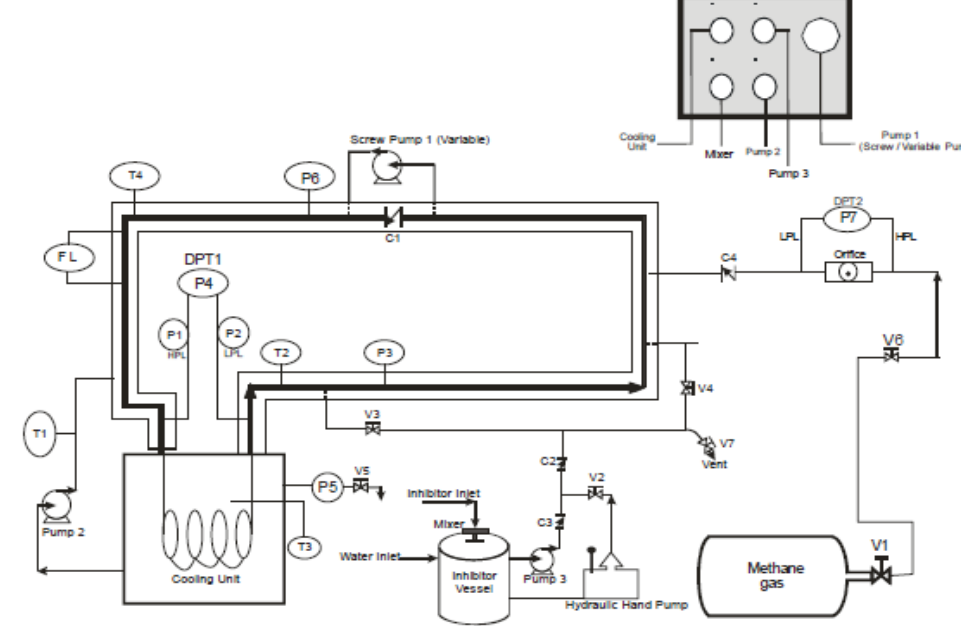
Figure 1. Process Flow Diagram (PFD) of laboratory mini flow loop [39].